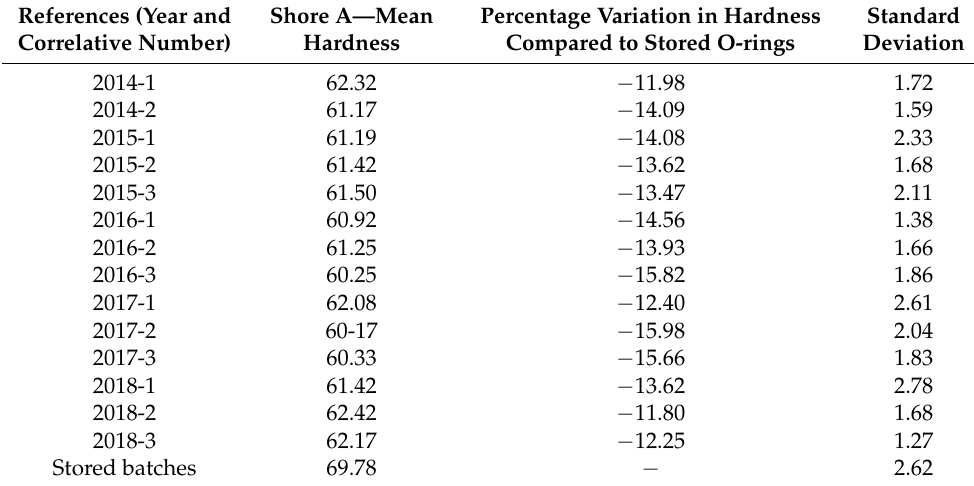
Table 3. Variation of every new supply hardness compared with stored ones and group standard deviation in measurements.